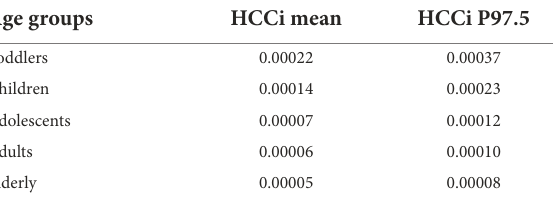
TABLE 4 Mean and 97.5th percentile hepatocarcinoma incidence (HCCi) values of the different age groups for 2019–2022, calculated with a probabilistic method.